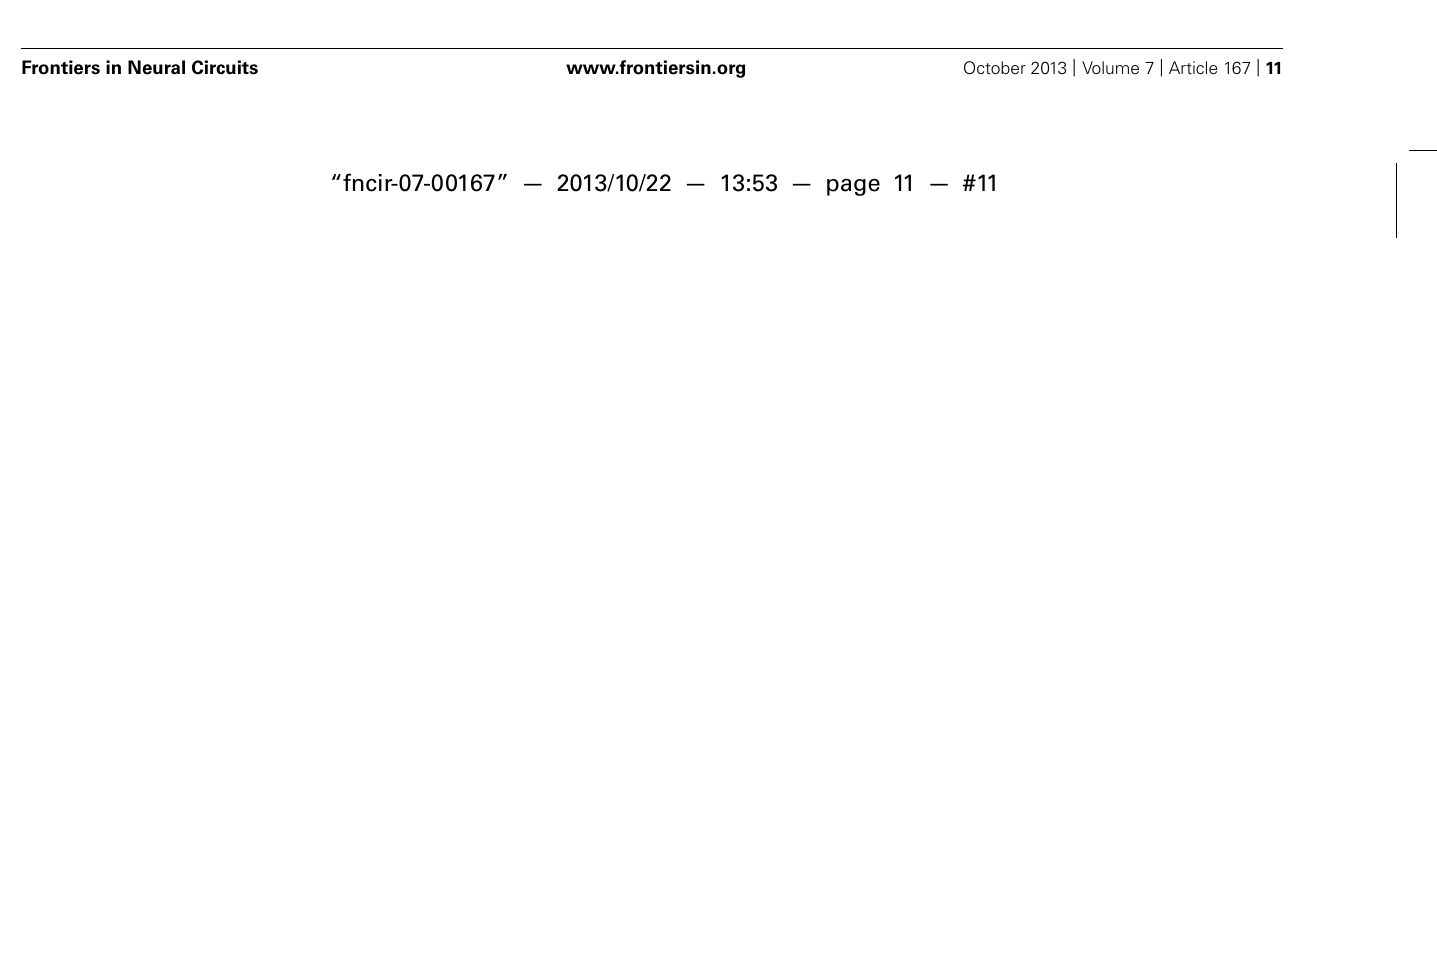
rate. In all plots, the light blue lines mark the 95% bootstrap confidence interval. The light blue column in all figures (300 and 380 s) marks the light stimulation period. P values on each plot give the significance level for the increase of FR, burst occurrence rate, or IBFR during the last 5 min of recording, respectively. The results are averages in 10 experiments in 10